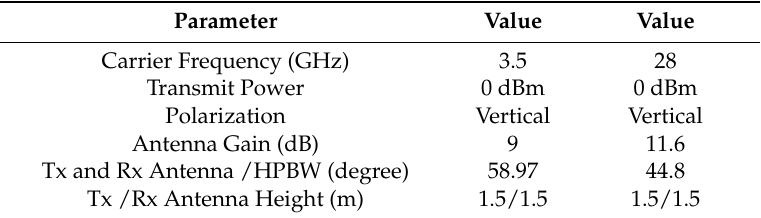
Table 1. Measurement